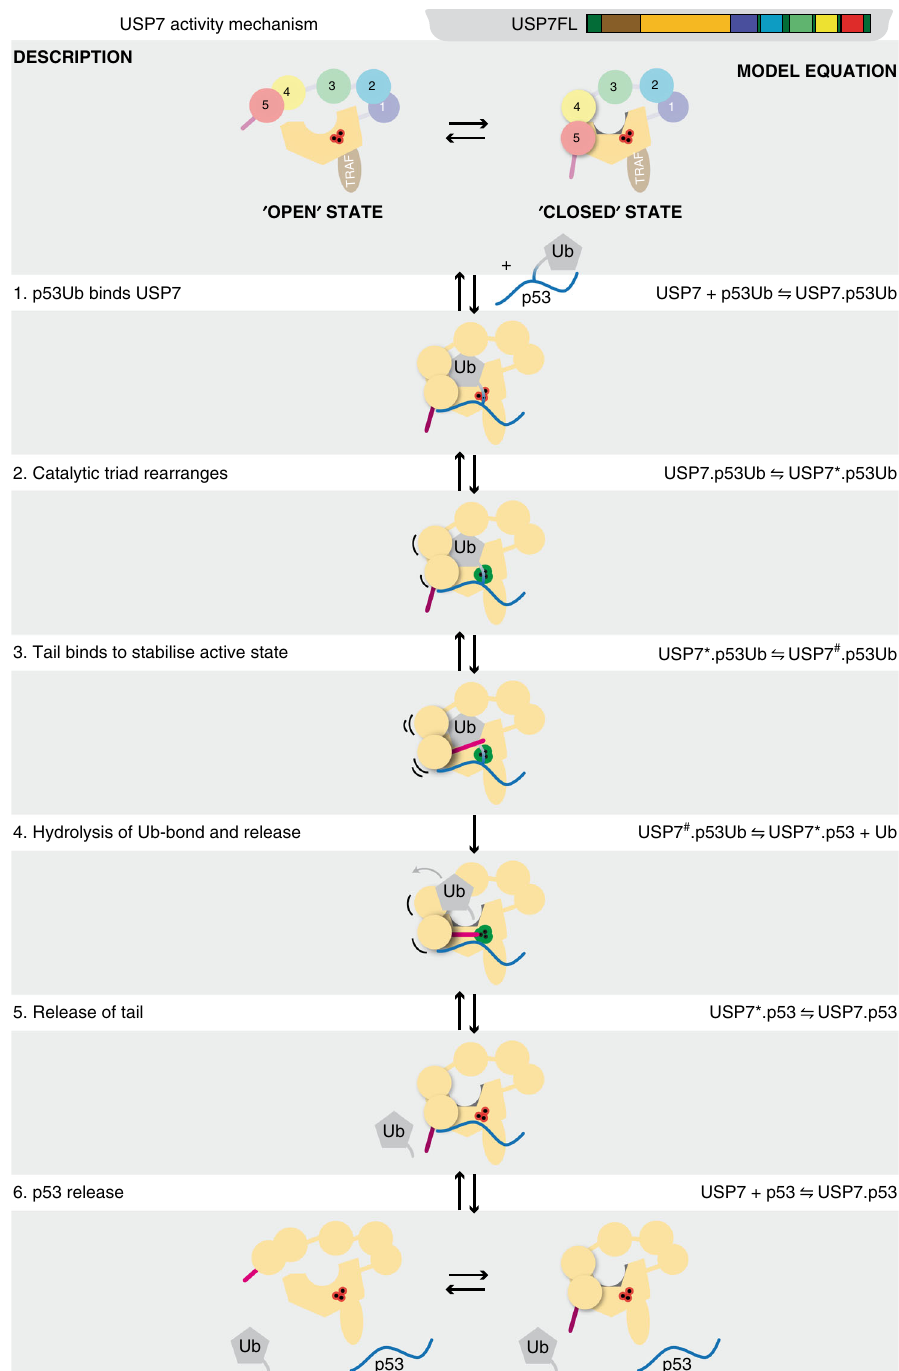
Fig. 7 Kinetic model for USP7 mechanism on p53Ub The kinetic model (equations) and their interpretation are depicted schematically. The weak af fi nity between Ubl45 and CD suggests that free USP7 is in equilibrium between an ‘ open ’ and ‘ closed ’ state 31 . The p53Ub substrate is bound by TRAF and CD, as well as an additional binding site that depends on the Ubl domains (1). Ubiquitin binding induces a rearrangement of the catalytic triad 33 (2), which dramatically increases the af fi nity the activating C-terminal tail, but diminishes the contact between CD and Ubl45. Binding of the tail peptide (3) stabilises the active state. This promotes the hydrolysis of the isopeptide bond, allowing Ub release (4). This in turn diminishes af fi nity for the C-terminal tail, causing its release (5) and the subsequent release of the p53 peptide (6) to return USP7 to the ground